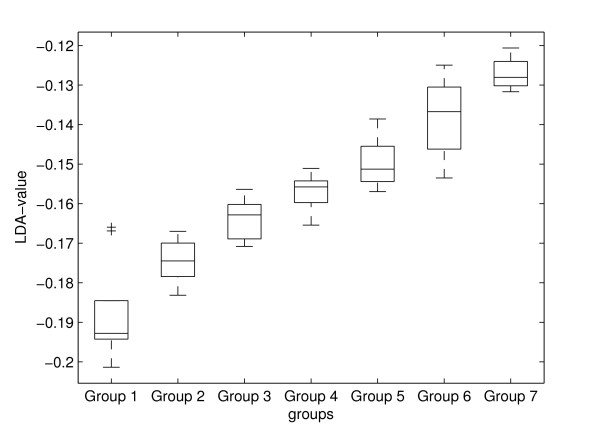
Box plot of the LDA-value for the seven groups. The graph shows the behavior of the LDA-value for the seven groups highlighting the differences among them.